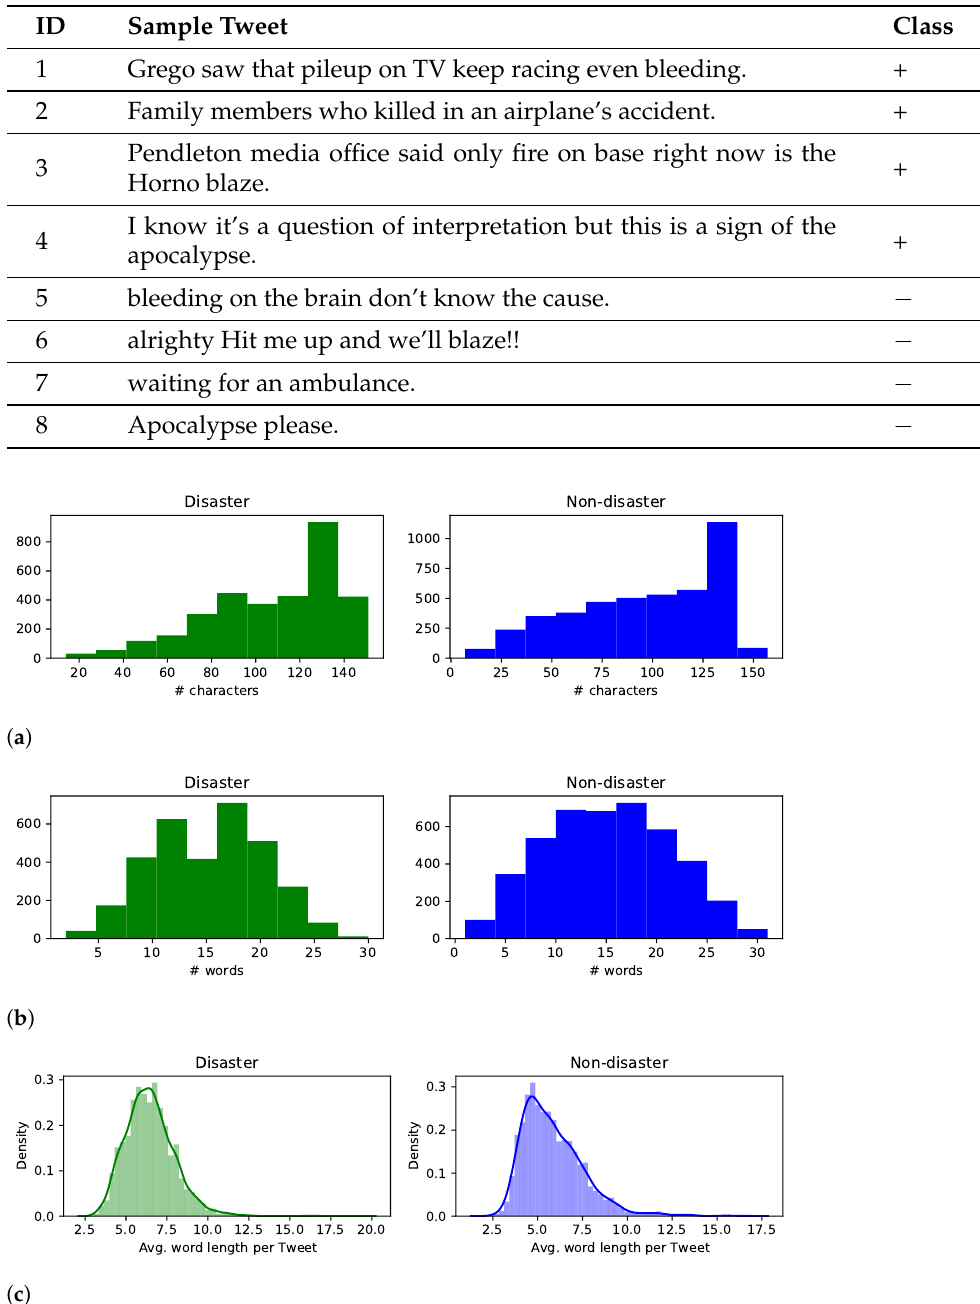
Figure 2. Stats of Tweets in the dataset. Histograms of ( a ) the number of characters per Tweet, ( b ) the number of words per Tweet, and ( c ) the average word length per Tweet, plotted for disaster Tweets ( left ) and non-disaster Tweets ( right